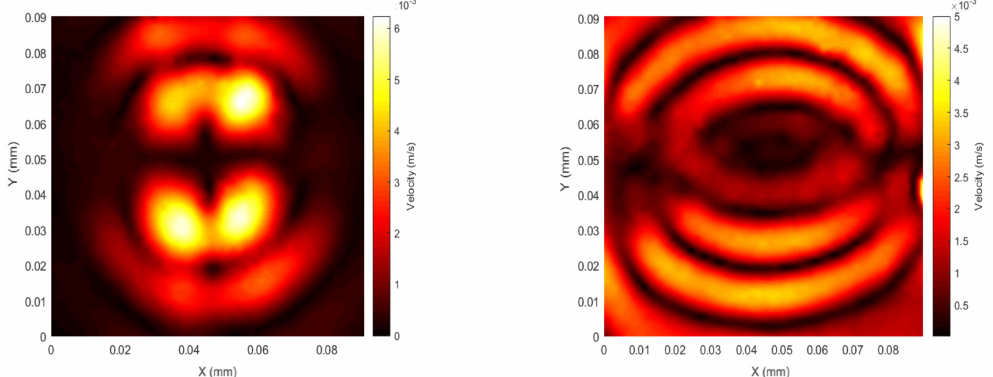
Figure 10. Top: Configuration 2—patch spatial scan at the beginning of the first peak of the signal ( left , t = 14 µ s) and the end of the pulsed wave ( right , t = 22 µ s); f = 120 kHz, 1 cycle sine wave.